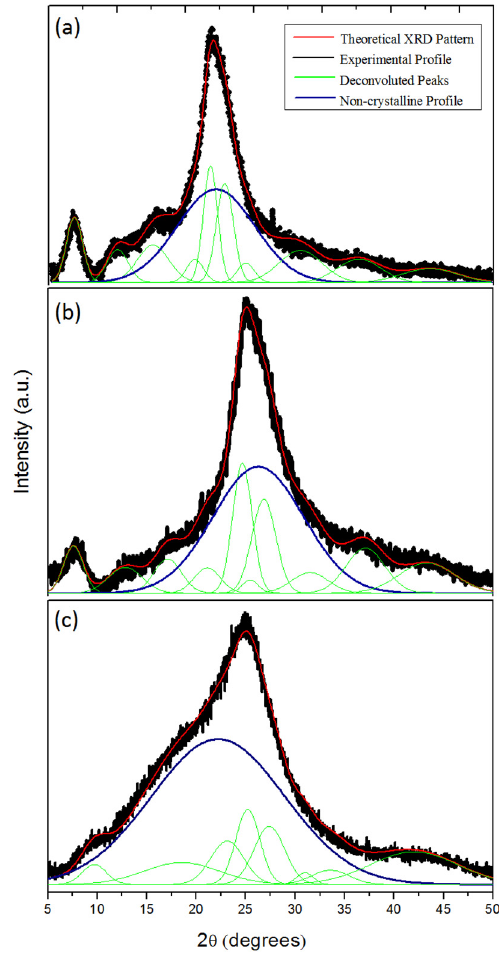
Figure 2. Peak deconvolution of the XRD patterns of the ( a ) untreated and treated POMA at ( b ) 100 °C and ( c ) 200 °C.